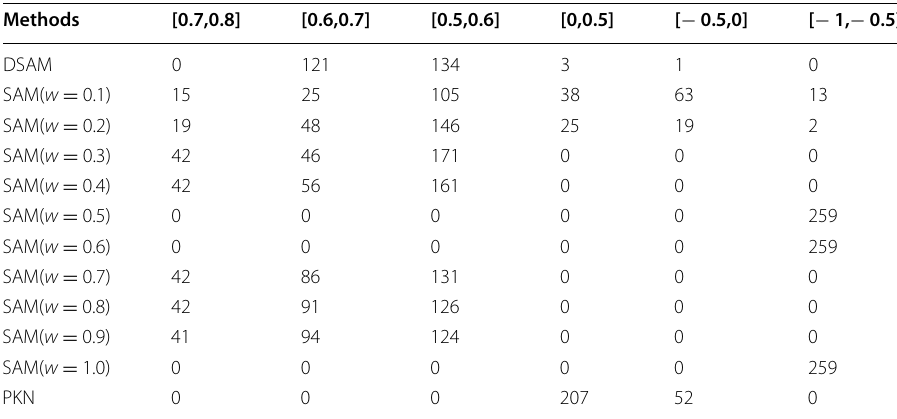
Table 2 Statistics of Spearman values calculated for 259 time slots of Iridium